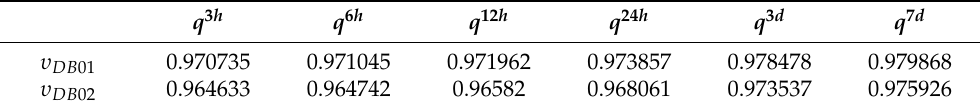
Table 1. Gray relation degree between rainfall characteristics and displacement